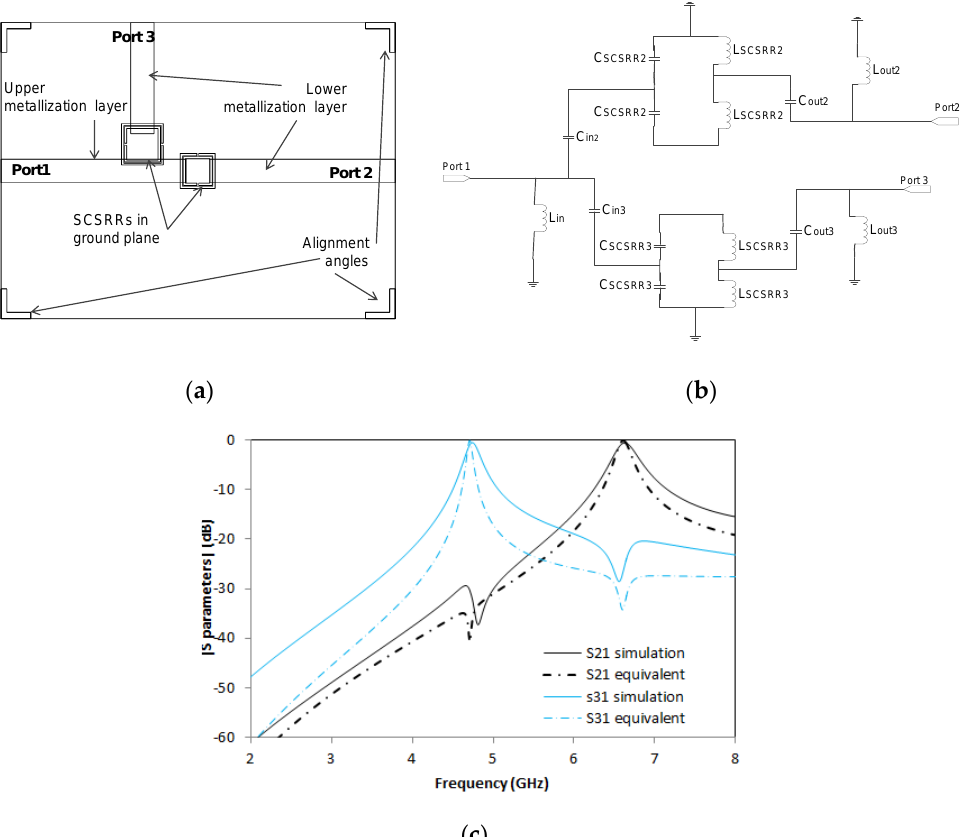
Figure 19. ( a ) Top view overlapped layer distribution of a 2-layer duplexer. ( b ) Equivalent circuit of diplexer made with two SCSRR on ground plane. ( c ) Simulated S21 (dashed black line) and simulated S31 (dashed blue line). Equivalent circuit S21 (dashed-dotted black line) and equivalent circuit S31 (dashed-dotted blue line).